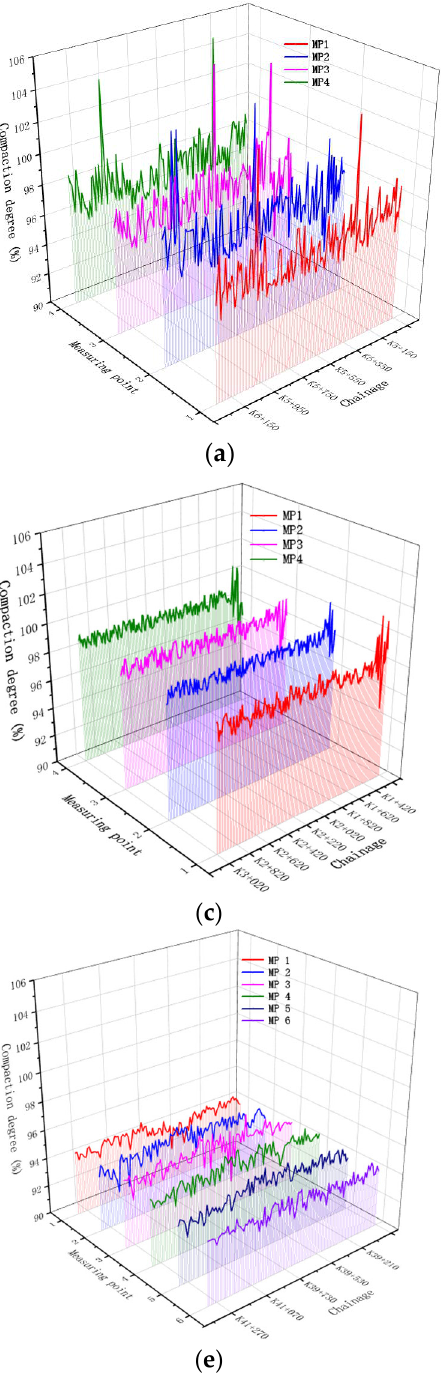
( d ) test section D; ( e ) test section E; ( f ) test section F.